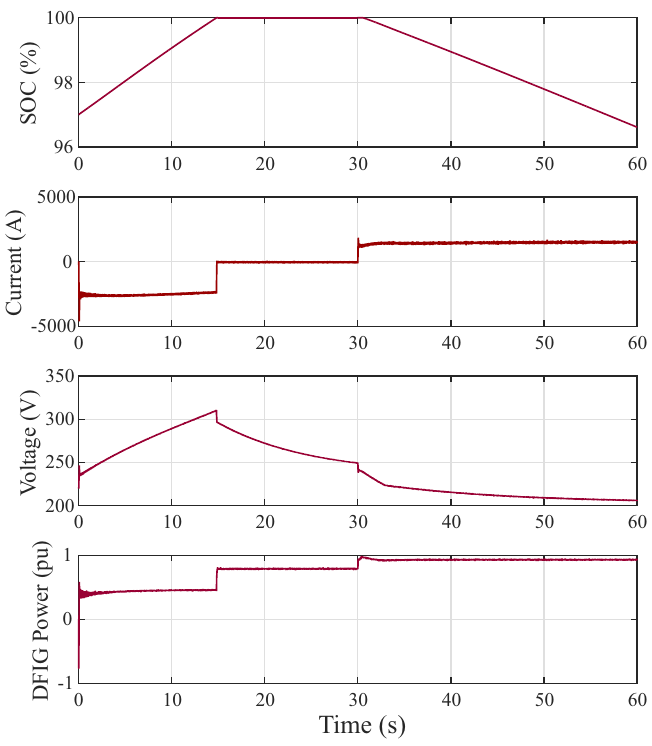
Figure 17. Battery SOC reaches